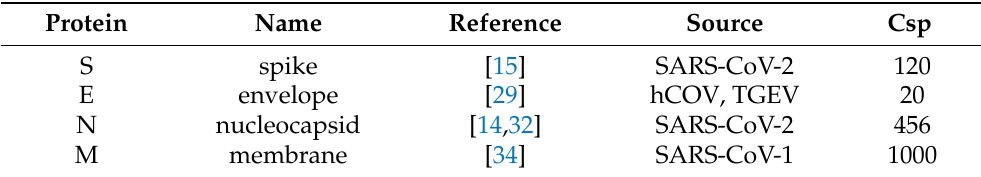
Table 2. Copy number of structural proteins. The Copy number of structural proteins (Csp) was determined based on extensive literature research. Besides the reference and the copy number of structural proteins, the investigated organism is given as a source.